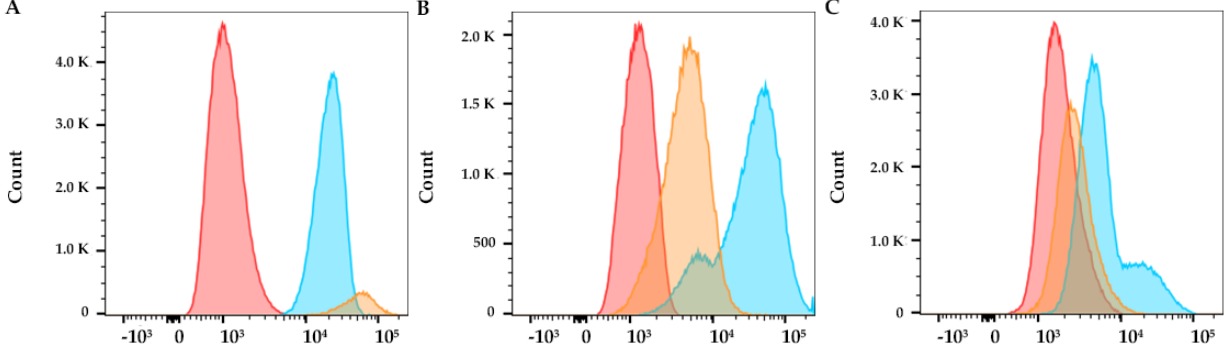
Figure 8 . Flow cytometry analysis after free C 8 (blue) or AS1411-AuNPs + C 8 (15:1, yellow) incubation for 24 h in ( A ) HeLa cancer cells, ( B ) HEC-1A cancer cells, and ( C ) NHDF non-malignant cells. Control condition (only cells) are indicated by red coloration.